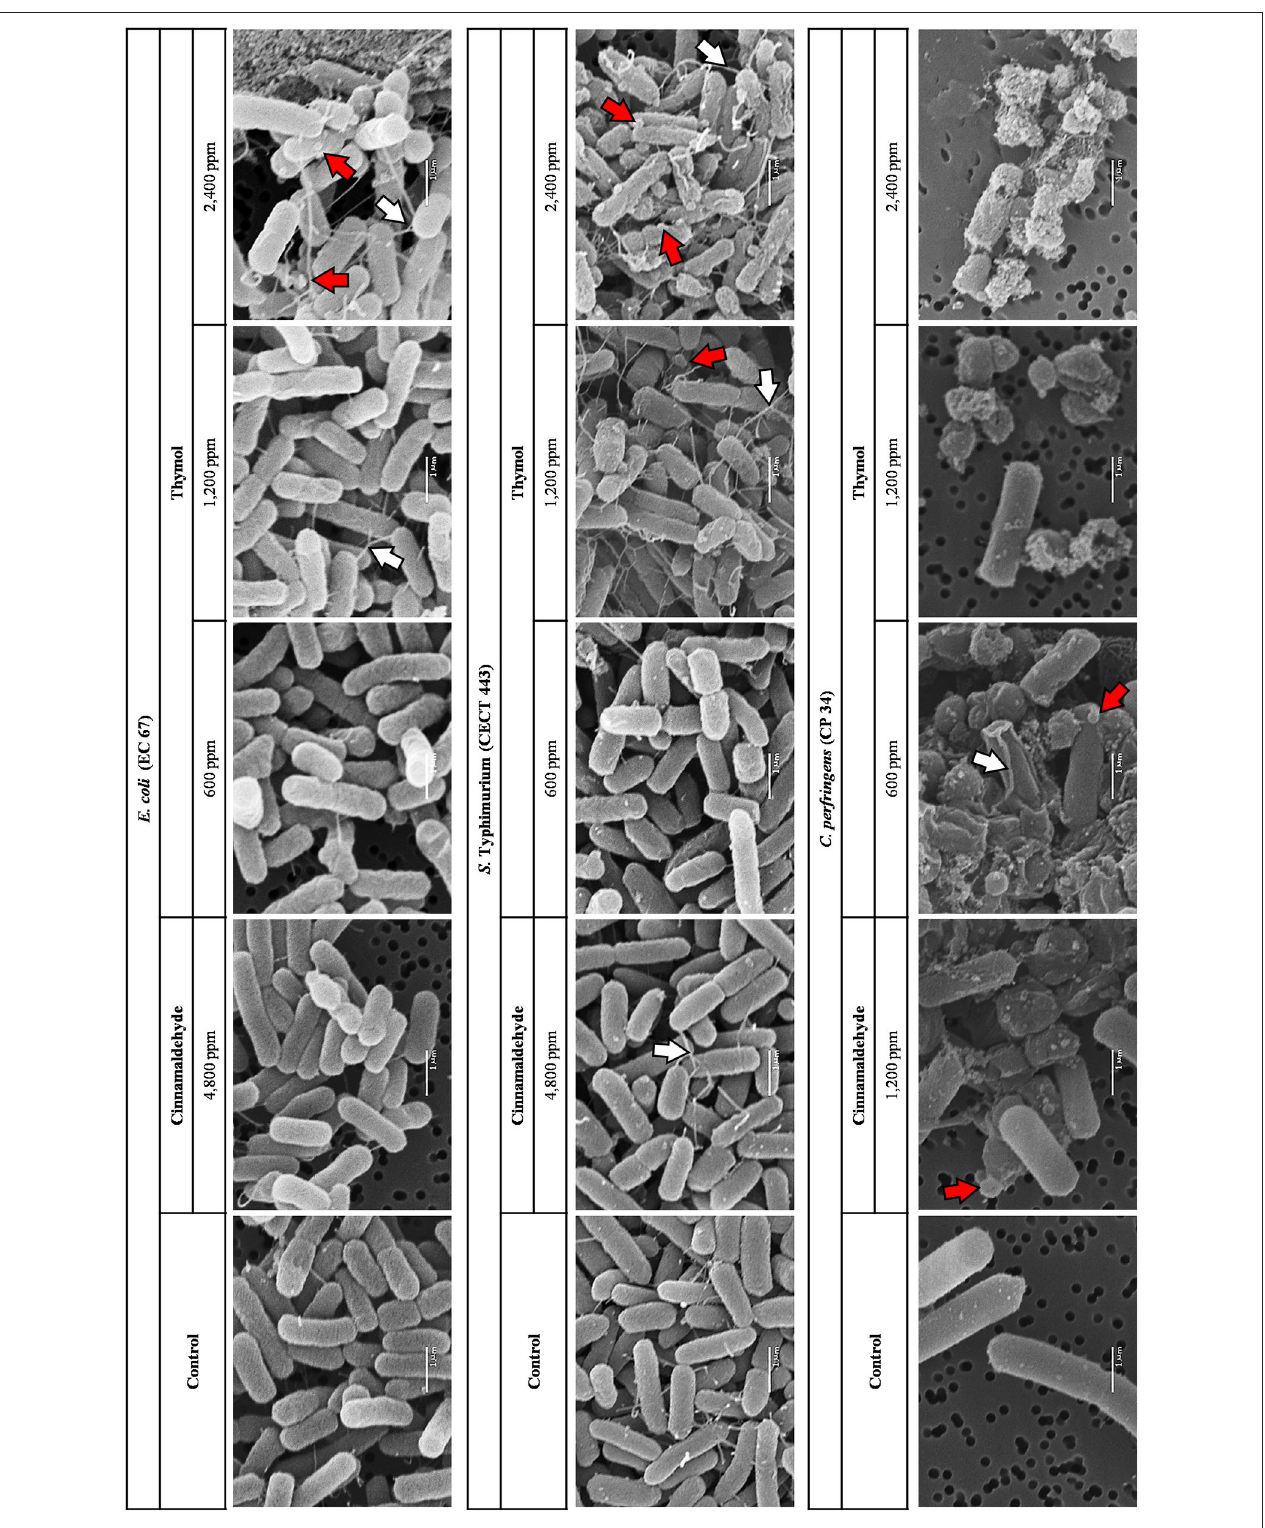
FIGURE 6 | SEM micrographs of the selected isolates of E. coli , S. Typhimurium, and C. perfringens exposed at the three highest concentrations tested of thymol and to 2MBC high of cinnamaldehyde for 90min at room temperature. Depending on the color inside the arrows, the red arrows point to blends and microvesicles while the white arrows show networks of intercellular and extending nanotubes.